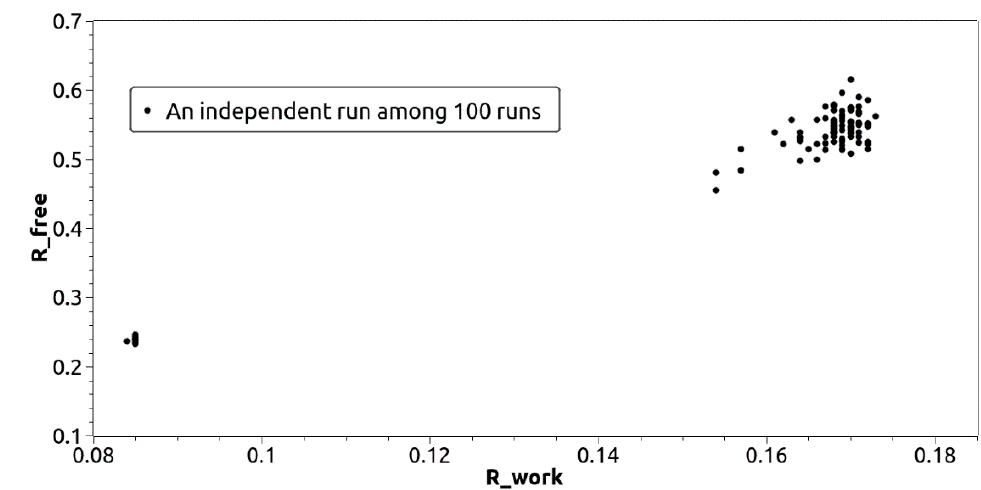
Figure 4. R values clearly separate the successful runs from the failed ones [35]. Each point on the figure corresponds to one of the 100 runs. Successful runs have smaller R work and R free at the same time. They are located at bottom left on the figure. Failed runs have larger R values. They are located at top right on the